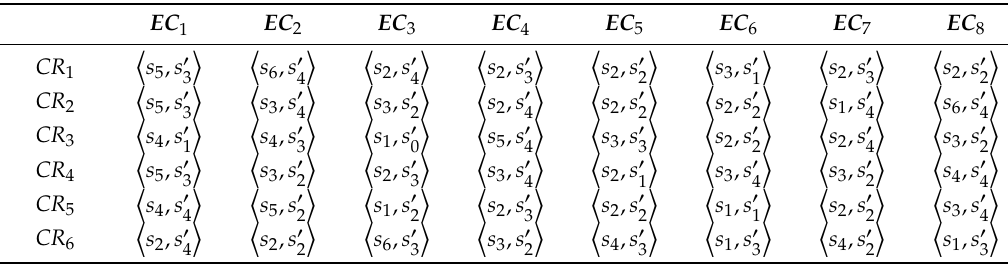
Table 5. The negative ideal assessment—maximum